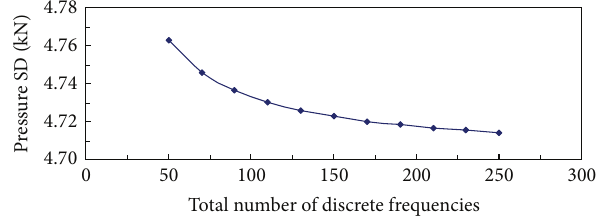
Figure 8: Maximum SD of vertical fastener pressure above bridge